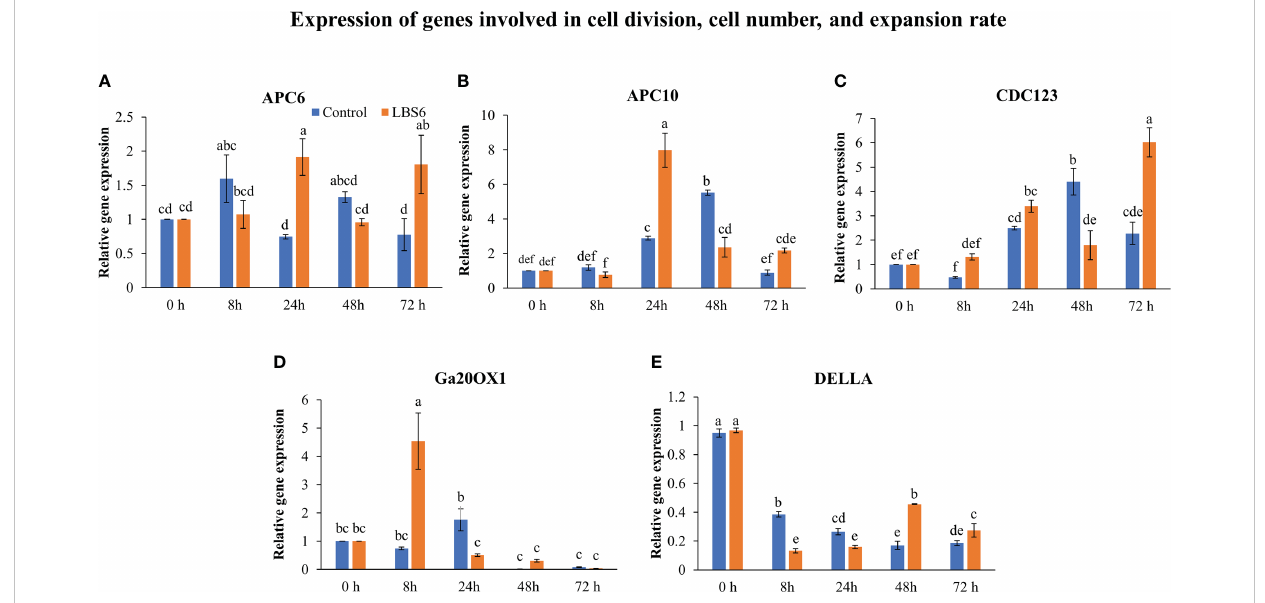
FIGURE 4 LBS6 regulated the expression of (A) APC6 , (B) APC10 , (C) CDC123 , (D) Ga20OX1 , and (E) DELLA involved in cell division, and cell number. The value in the graph represents the relative gene expression. The values were presented as mean ± SE of three independent replicates, and signi fi cantly different mean values were represented by different